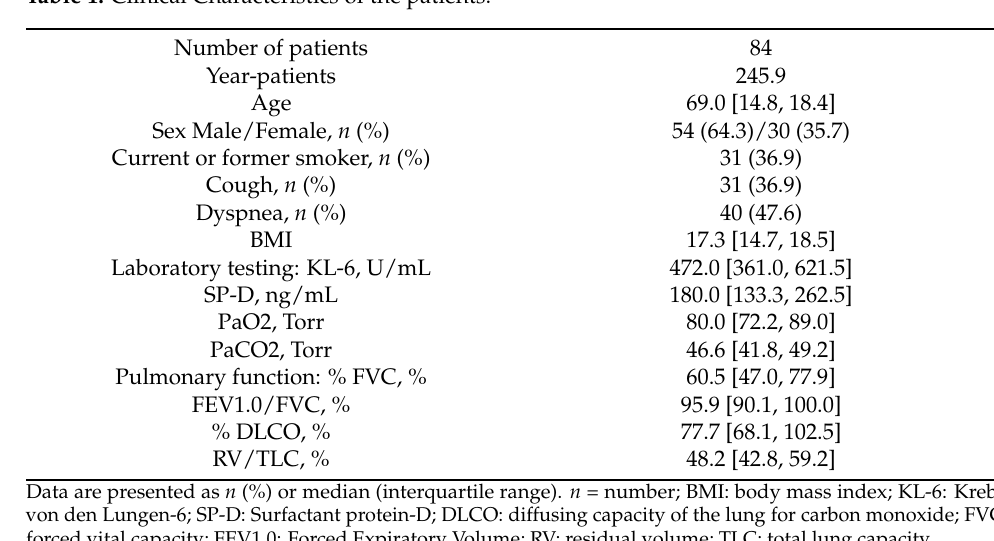
Table 1. Clinical Characteristics of the patients.